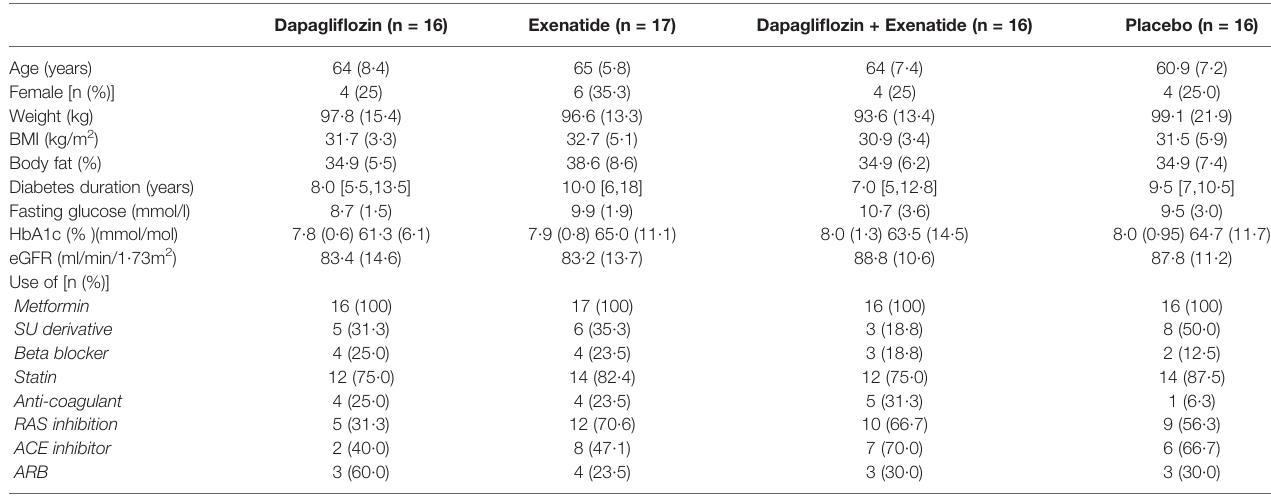
TABLE 1 | Baseline characteristics.